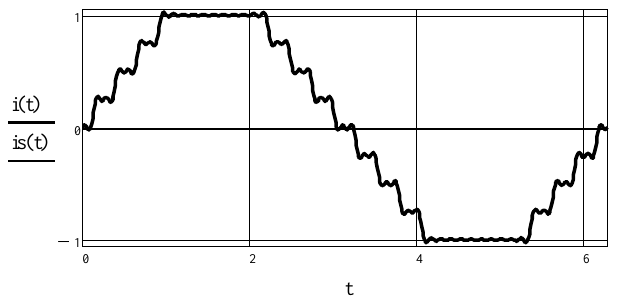
Fig. 10. The instantaneous value of 24-pulse rectifier input current.